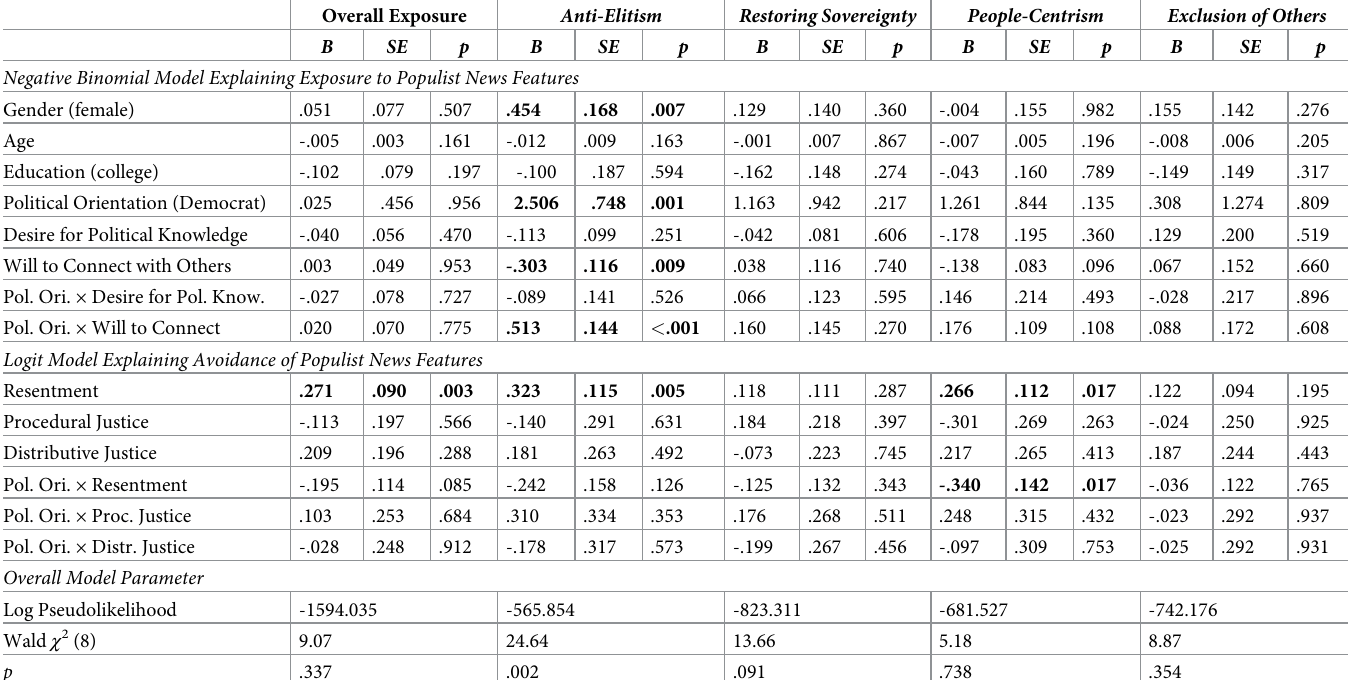
Table 2. Zero-inflated negative binomial regression model simultaneously predicting selective exposure to and selective avoidance of populist news